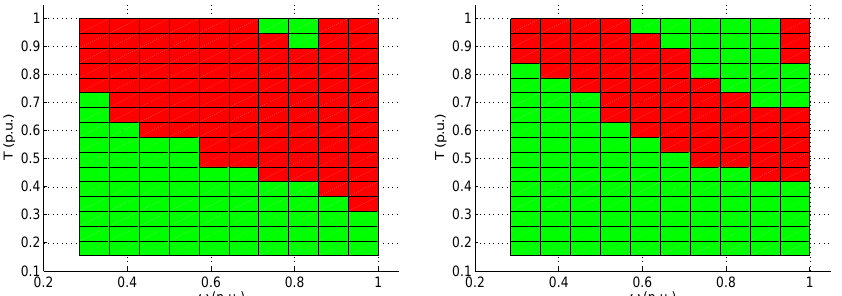
Figure 4. Constraint satisfaction of two PCC with fixed parameters: Case A for λ xy = 0.5, λ sw = 0 ( left ) and Case B for λ xy = 0.1, λ sw = 60 × 10 − 5 ( right ).